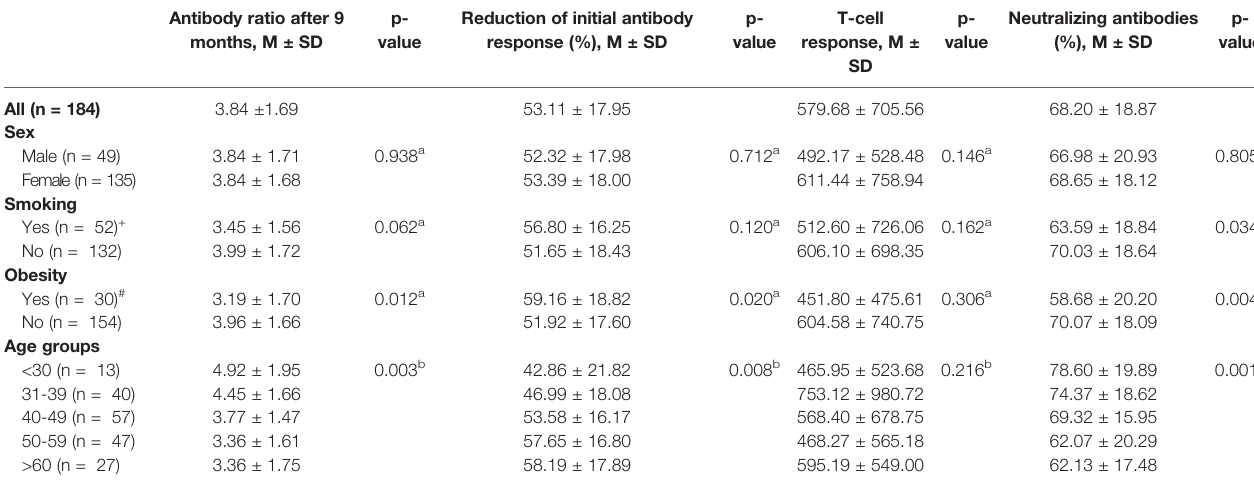
TABLE 2 | Participants 9 months after second dose of BioNTech/P fi zer vaccine (n = 184). Antibody ratio after 9 p- Reduction of initial antibody months, M ± SD value response (%), M ± SD